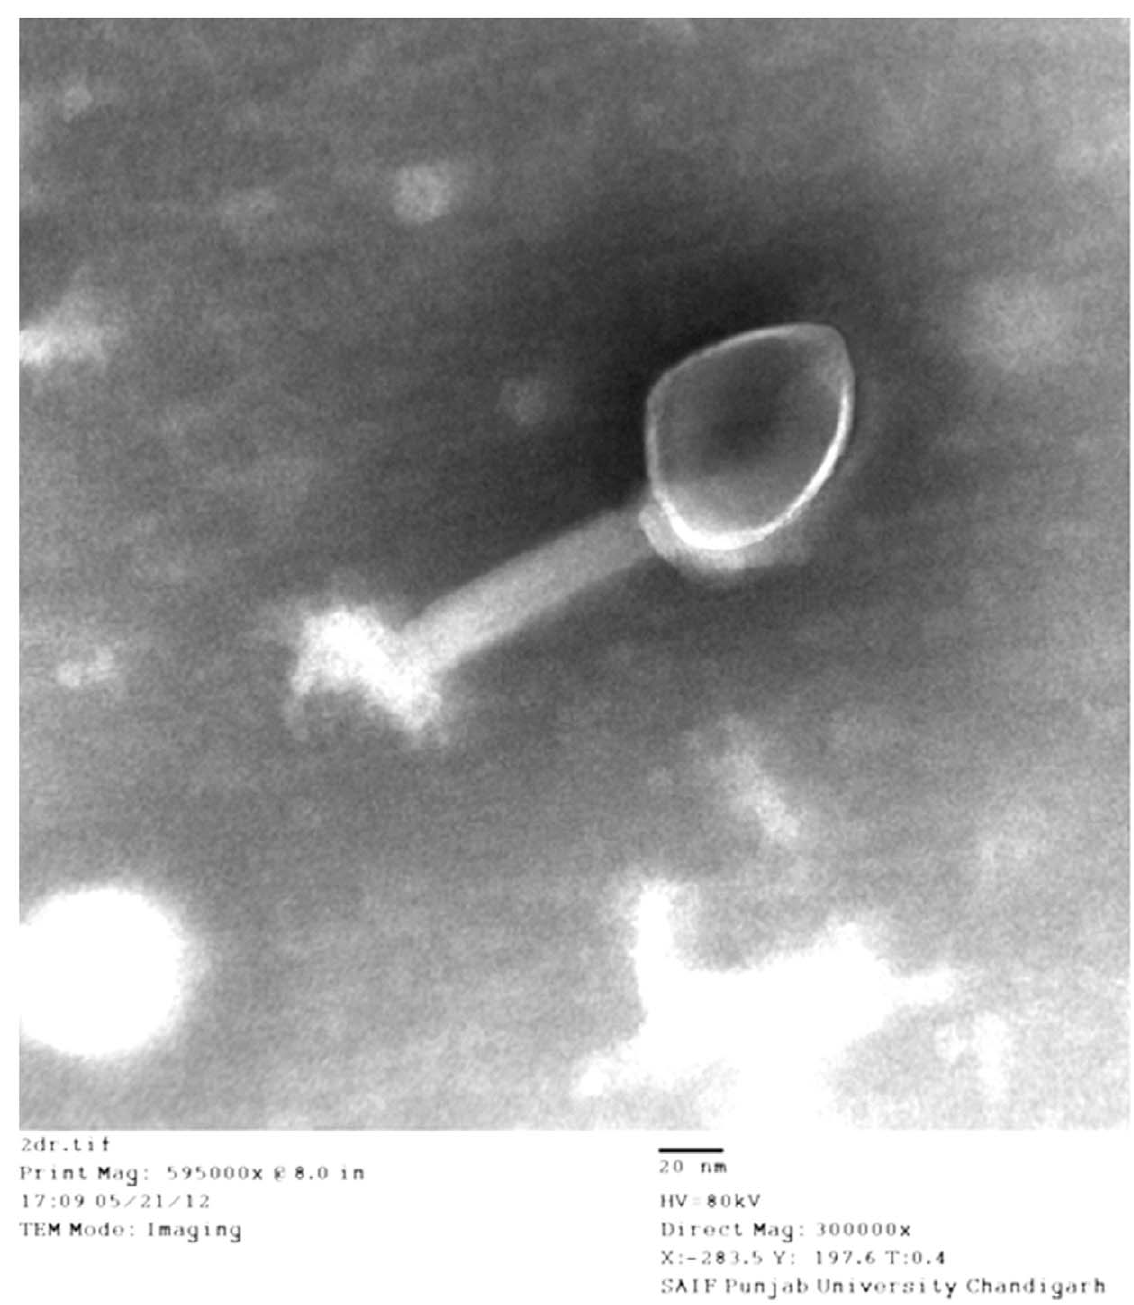
Figure 1. Transmission Electron Micrograph of S.aureus specific phage MR-10.